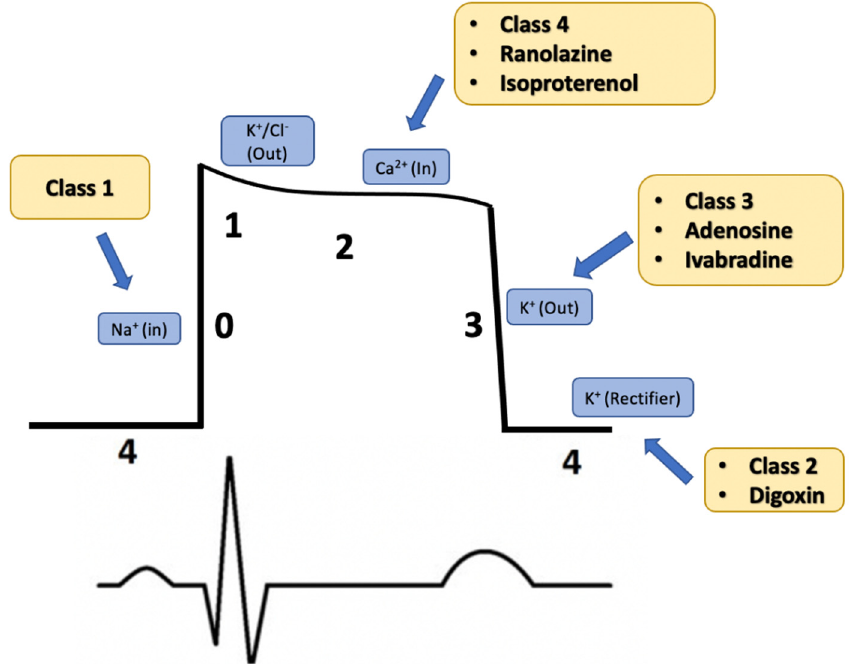
Figure 1. Anti-arrhythmic medications grouped by class and illustrated by the effect the cardiac action potential. Each number reflects a change in ion channels: “0” responding to influx of sodium, “1” and “3” corresponding to repolarizing efflux of potassium, “2” corresponding influx to calcium, and “4” corresponding to baseline potential through the Na/K pump.